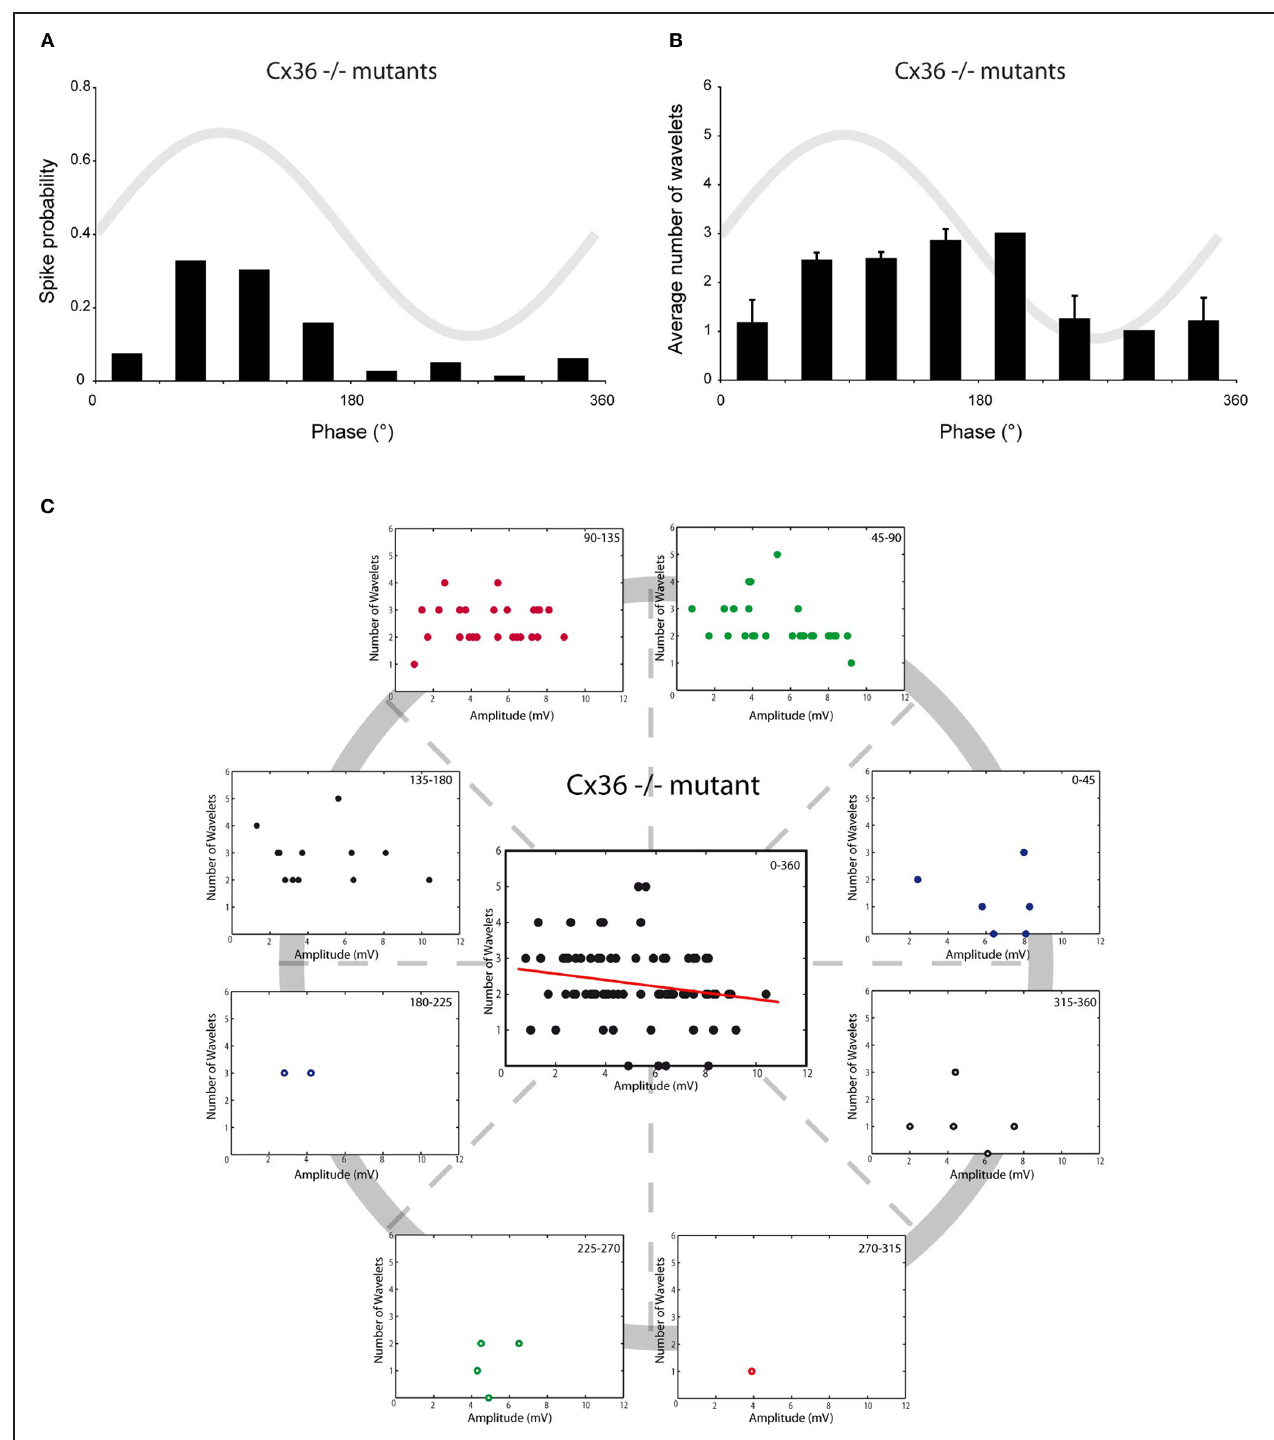
between number of wavelets and amplitude of SSTO were plotted for each phase-bin. The center graph shows the correlation between the amplitude of the SSTOs and the number of wavelets of all data (all phase-bins together) measured in Cx36 − / − mutant mice. Least squares linear regression lines and correlation coefficients were computed [ r CX36 = − 0 . 20, n = 83, and p > 0 . 05 ( t